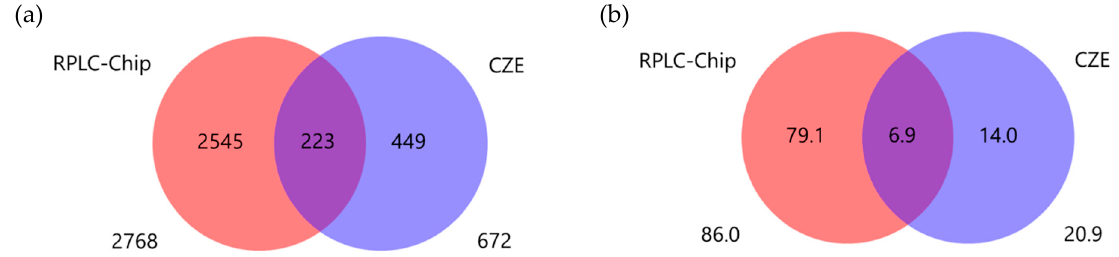
Figure 3. ( a ) Uniqueness of identified proteins and ( b ) percentage of identified proteins by analyz- ing LP-1 cell lines using RPLC-Chip and CZE coupled with DTIMS-QTOF. LP-1 cell lines using RPLC-Chip and CZE coupled with